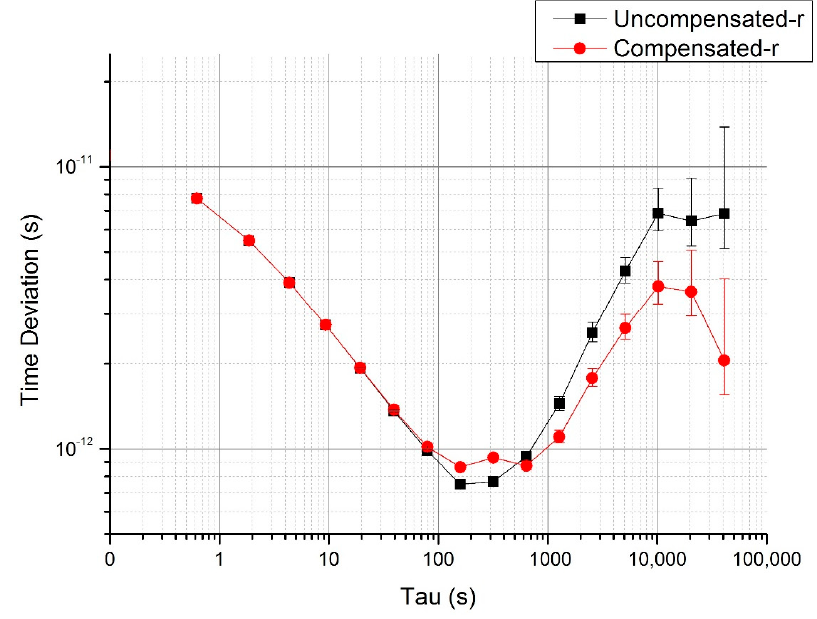
Figure 7. TDEV before and after compensation in the temperature rising period.